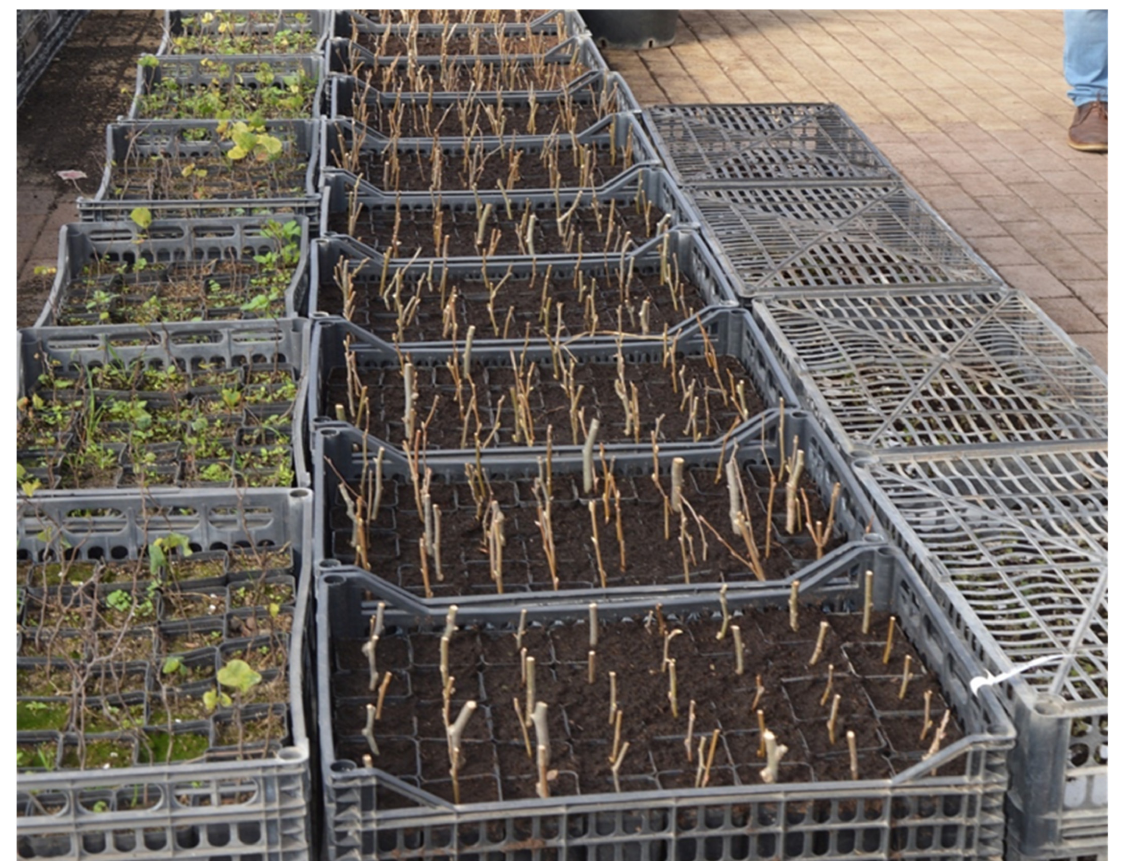
Figure 8. Cuttings prepared from Populus alba , Quercus virgiliana and Ulmus minor plants.